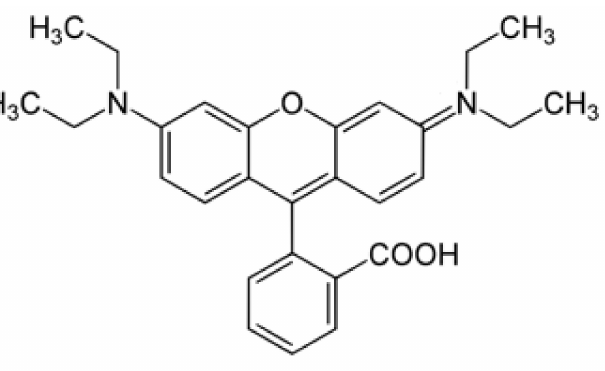
Figure 2. Chemical structure of Rhodamine B dye (Basic Violet 10, C.I.45170, Cationic, Xantenic dye; MW = 479.2 g mol − 1 ; λ max = 550